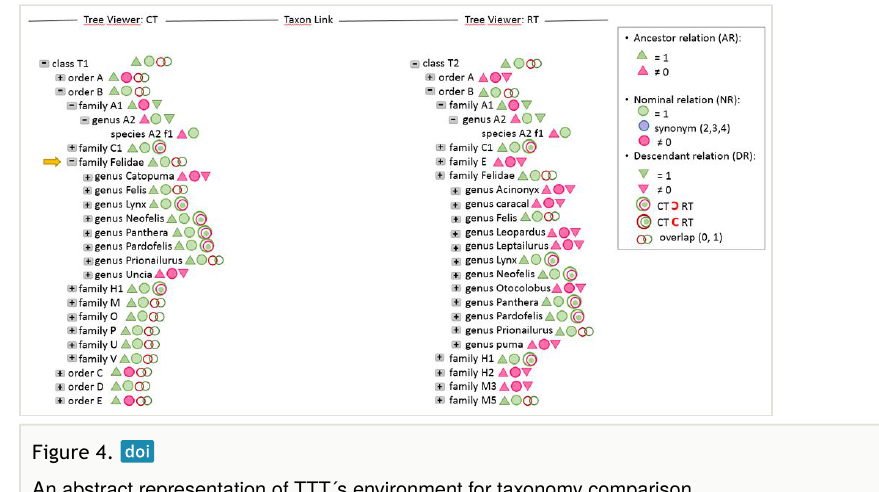
An abstract representation of TTT´s environment for taxonomy